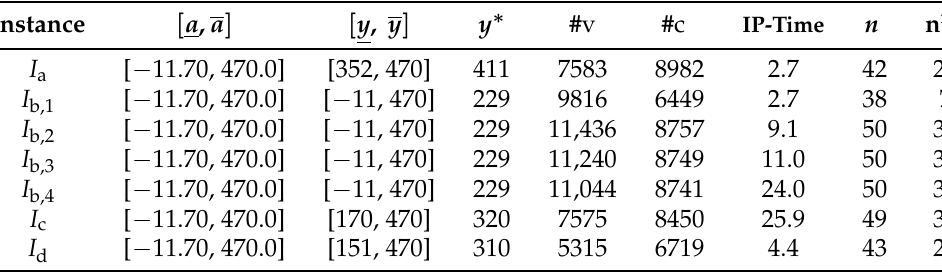
Table 8. Results of Stage 4 for B P .